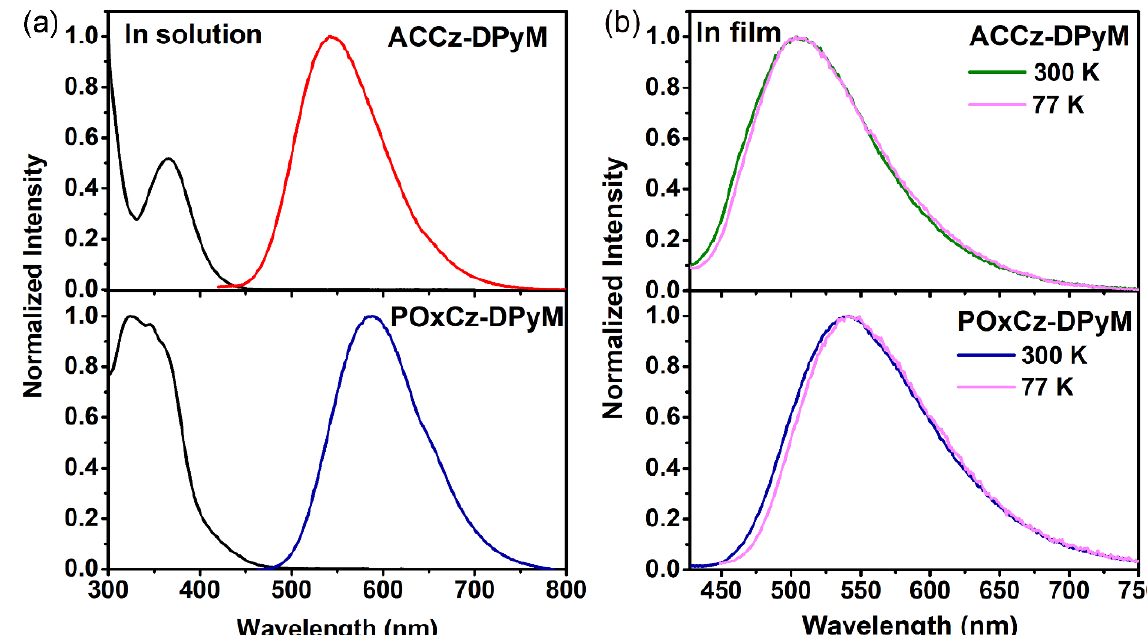
Figure 2. ( a ) UV spectra and PL spectra in dilute toluene solution for ACCz-DPyM and POxCz- ( b ) PL spectra in film (doped in mCBP with 8 wt%). ( λ ex = 360 Table 1. The test data of ACCz-DPyM and POxCz-DPyM.